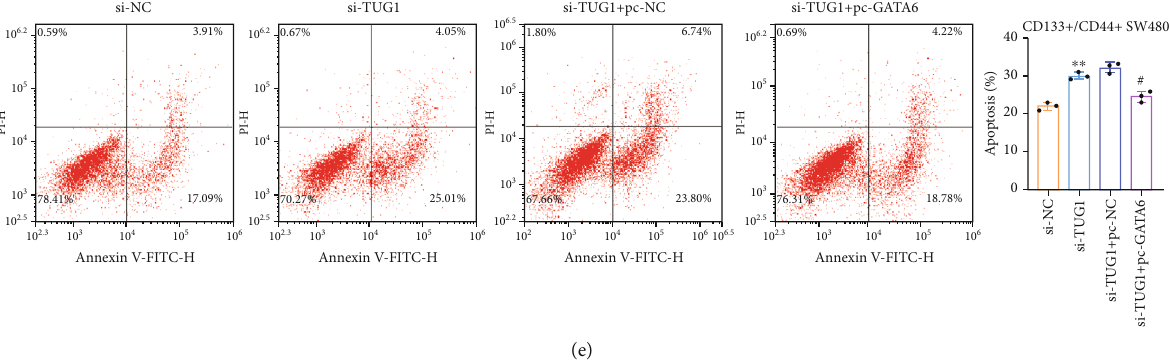
Figure 4: Veri fi cation of the regulation of the lncRNA TUG1/GATA6 axis on the characteristics and chemoresistance of CRC stem cells. si- TUG1 and/or pcDNA-GATA6 were transfected into CD133 + /CD44 + isolated from SW480 cells. (a) qRT-PCR and Western blot assays were carried out to identify the transfection e ffi ciency of pcDNA-GATA6. (b) Analysis of the protein levels of ALDH1 and Nanog in CD133 + /CD44 + isolated from SW480 cells using Western blot. (c) The formation of clonal spheres was assessed by sphere formation assay. si-TUG1 and/or pcDNA-GATA6 were transfected into CD133 + /CD44 + isolated from SW480 cells, and the cells were then treated with 4 μ M oxaliplatin for 48h. (d) The viability of CD133 + /CD44 + isolated from SW480 cells was analyzed using a CCK-8 assay. (e) Analysis of the apoptotic ability of CD133 + /CD44 + isolated from SW480 cells by fl ow cytometry. ∗∗ P < 0 : 01 vs. si-NC. ∗∗∗ P < 0 : 001 vs. si-TUG1+pc-NC. # P < 0 : 05 and ### P < 0 : 001 vs.